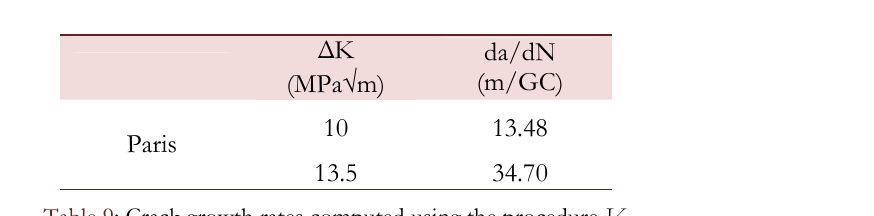
Table 9: Crack growth rates computed using the procedure V.